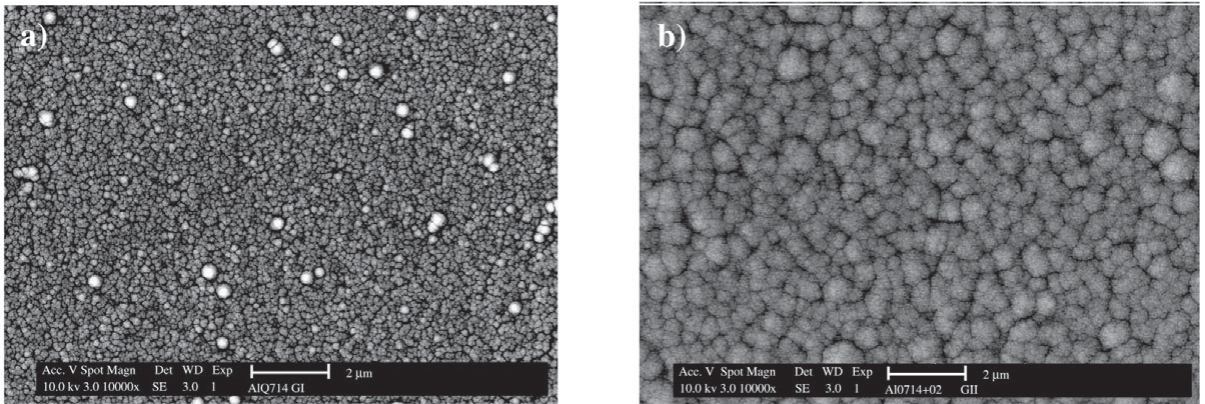
Figure 2 . SEM surface morphologies of the coatings produced by a) co-deposition of 310 stainless steel and Al, and b) reactive deposition of Al with O 2